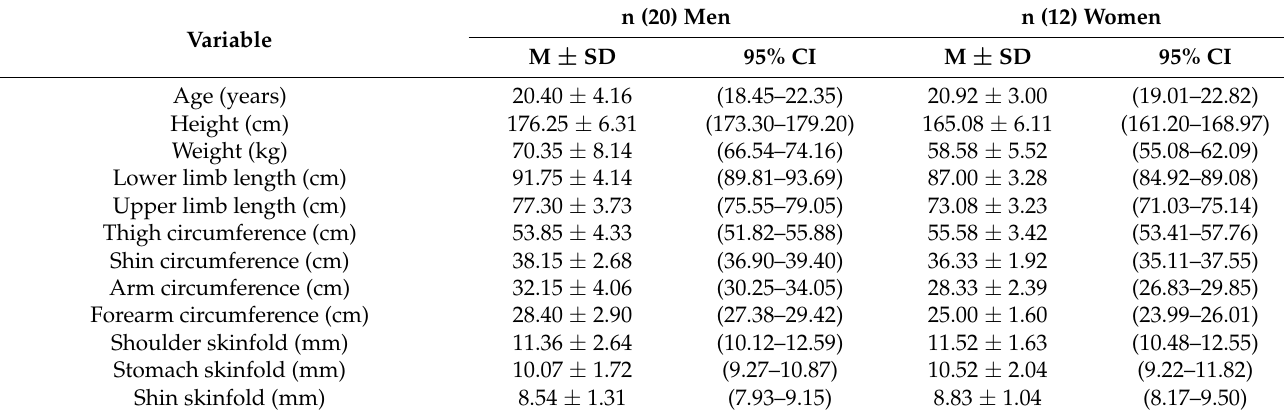
Table 1. Mean values of the anthropometric and physical fitness characteristics and special motor fitness test results of male and female karate